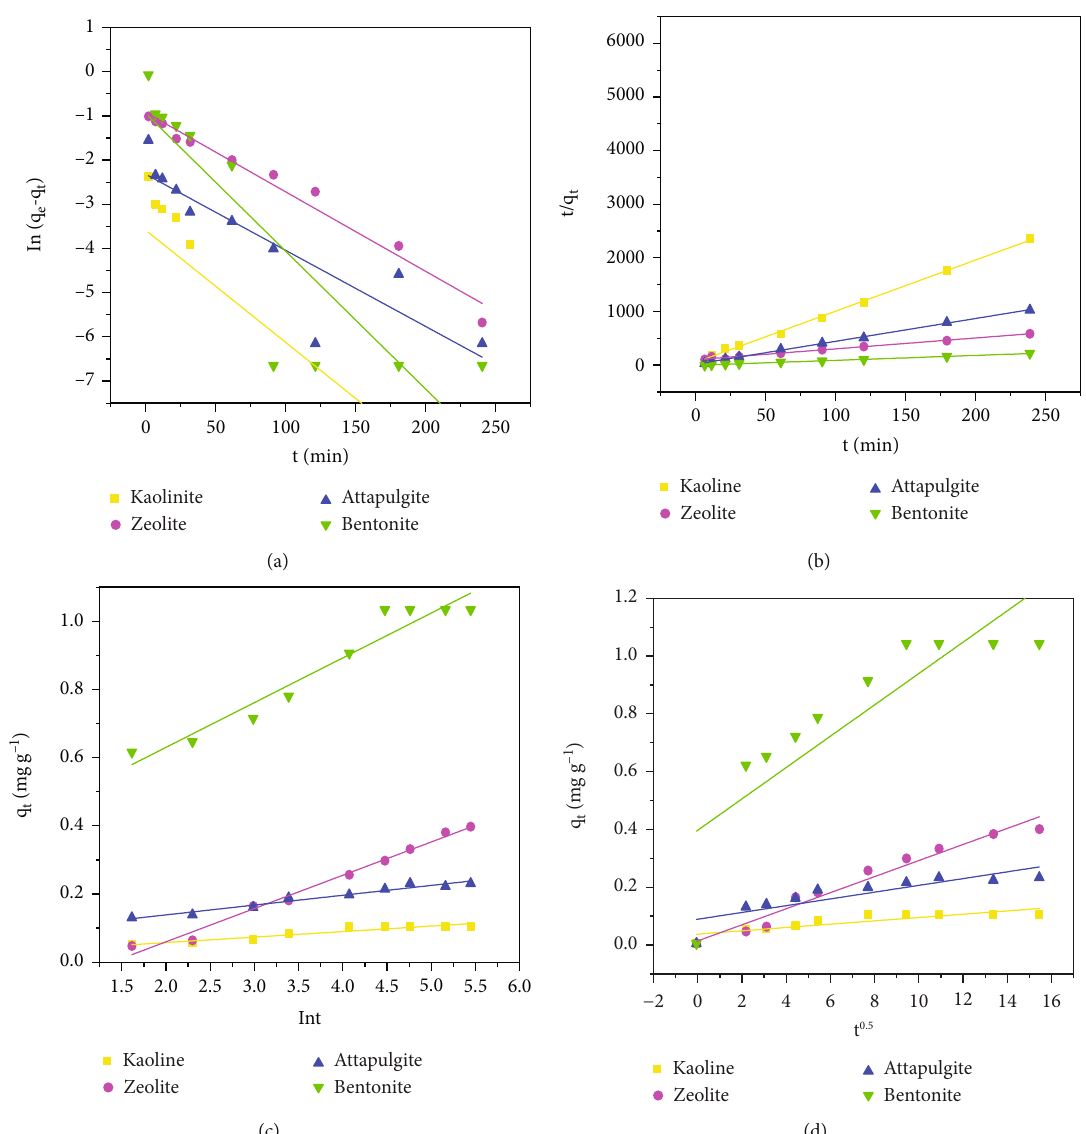
= 10 mg · L − 1 , V = 25mL , and temperature at 0